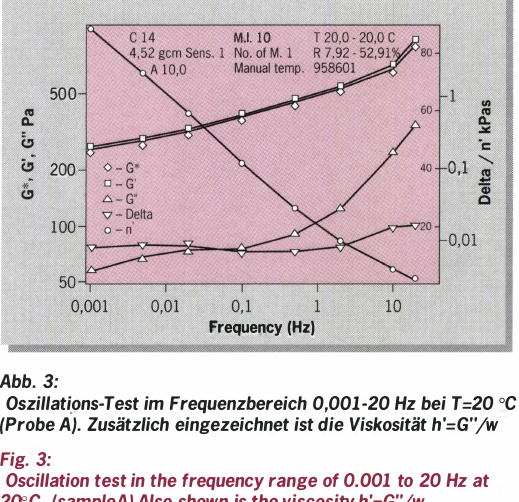
Fig. 3: Oscillation test in the frequency range of 0.001 to 20Hz at 200C (sampleA).Aiso shown is the viscosity